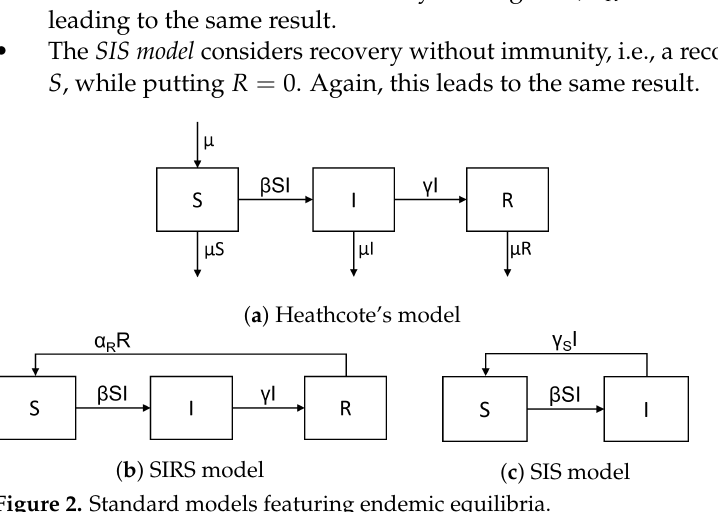
Figure 2. Standard models featuring endemic equilibria.